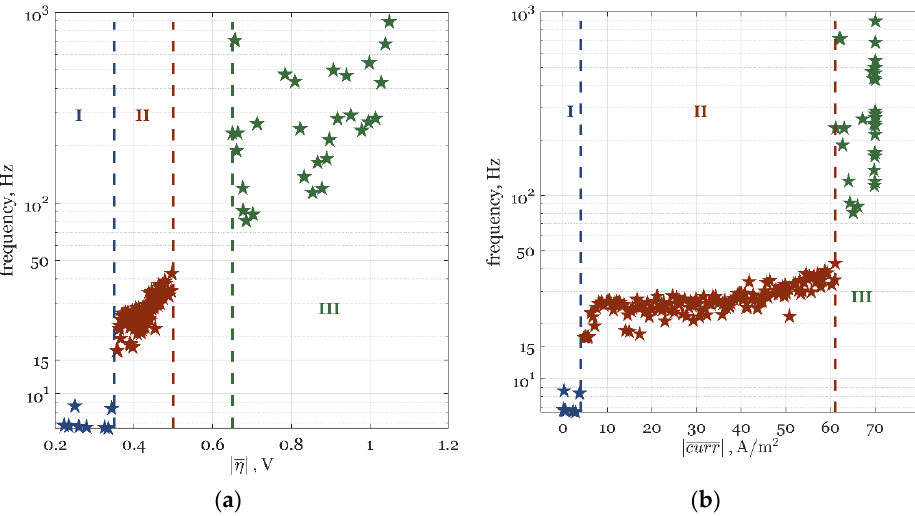
Figure A2. Optimal frequencies of modulation at different time ‐ average: ( a ) overpotentials (CI) and ( b ) current densities (BI). The optimal solutions are displayed in the three distinct Zones: Zone I, of dominant kinetics and no ORR (blue stars); Zone II, where the FP operation is superior (red stars); and Zone III, where the FP operation offers a negligible PI potential (green stars).